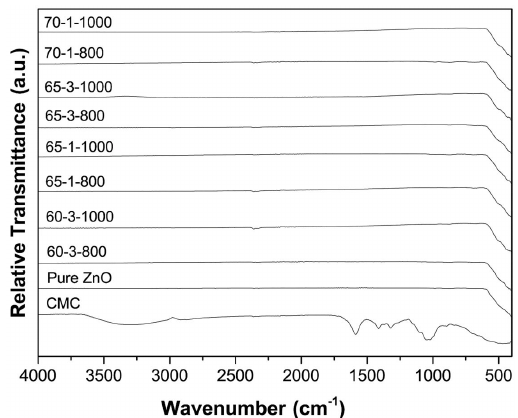
Figure 8. DRS results for heat-treated compositions at (a) 800 ºC/2 h and (b) 1000 ºC/2